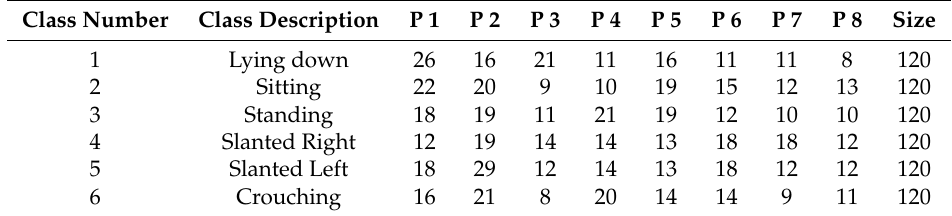
Table 1. Number of images captured to build the data set, by class, for each of the eight persons: P i , i =